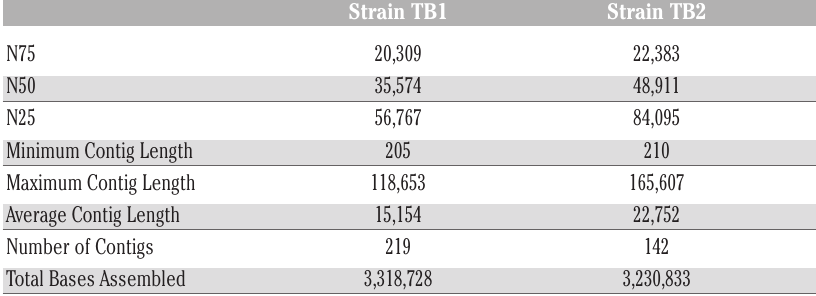
Table 1. Assembly statistics genomes of two strains of Janibacter (TB1 and